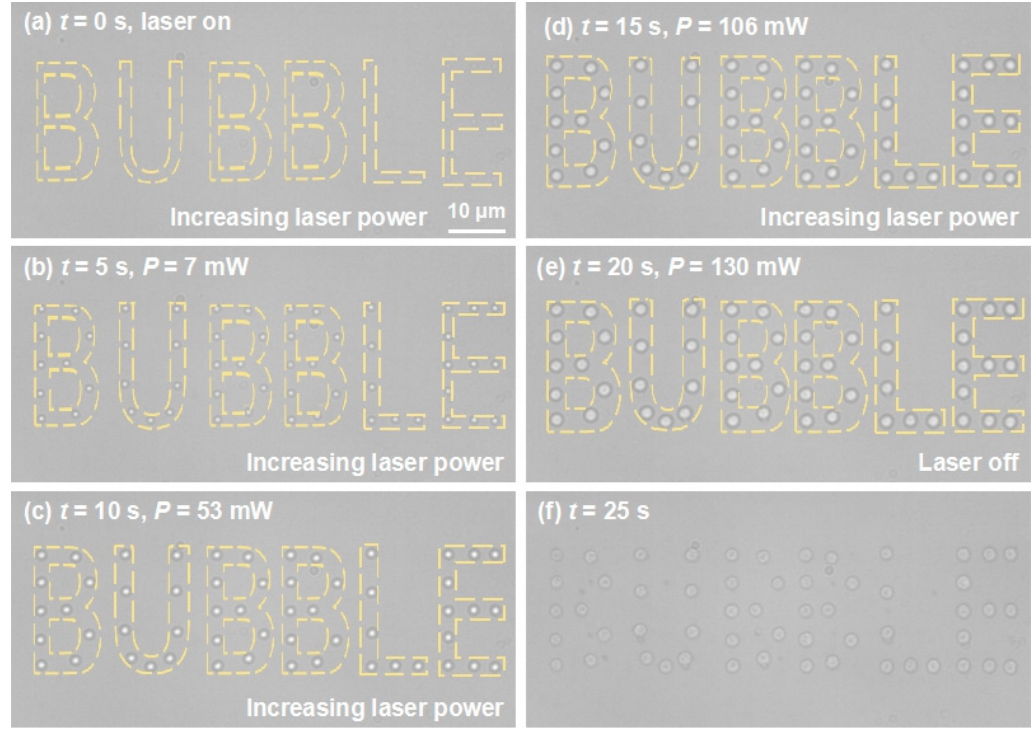
Figure 4. Evolution of the grown microbubble pattern “bubble” with increasing power ( P ) of the laser beam. ( a ) At time t = 0 s, the laser was turned on and some microbubbles with D of ~700 nm appeared at designed positions. ( b ) At t = 5 s, P increased to 7 mW and the microbubble diameter in ( a ) grew to 1.4 μ m. ( c ) At t = 10 s, P increased to 53 mW and the D of the microbubbles grew to 1.9 μ m. ( d ) At t = 15 s, P increased to 106 mW and the microbubble diameter grew to 2.5 µ m. ( e ) At t = 20